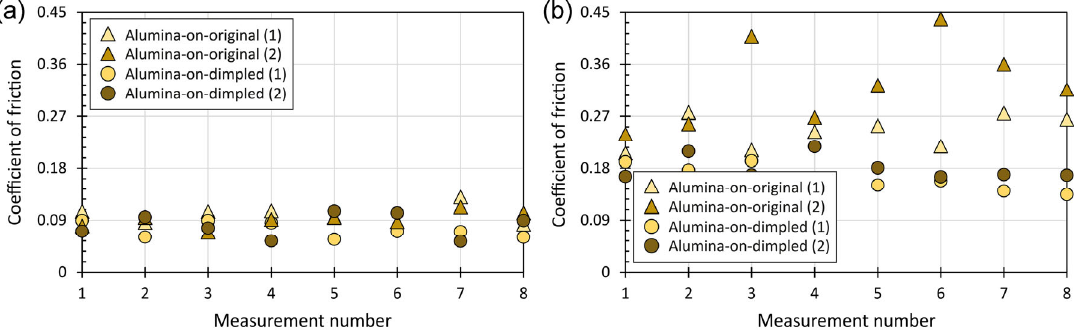
Fig. 5 Results of friction coefficient for alumina ceramic femoral head using (a) PBS and (b) model SF.